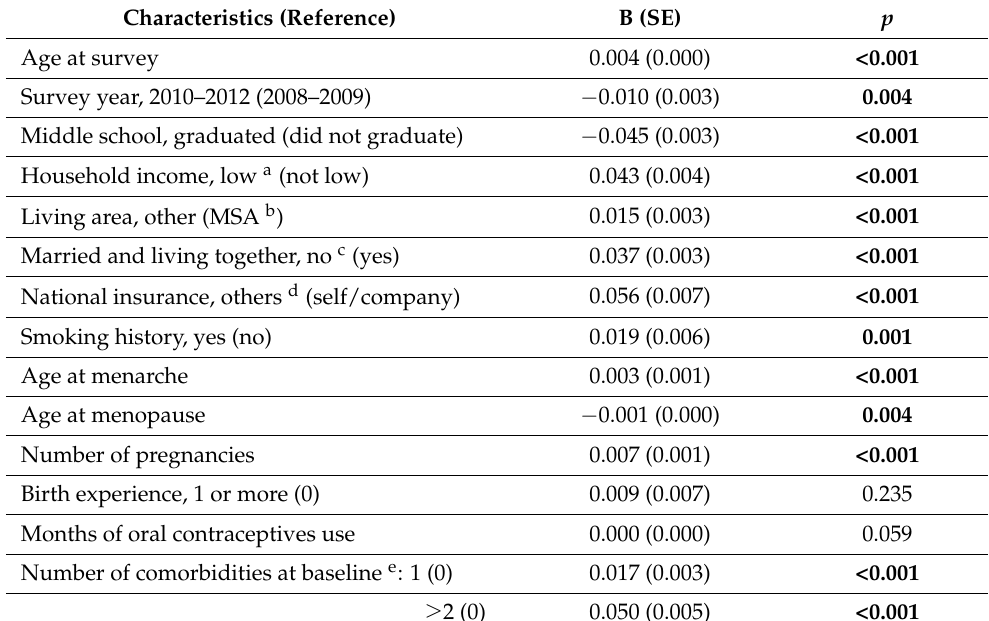
Table 4. Characteristics associated with frailty (IPTW regression